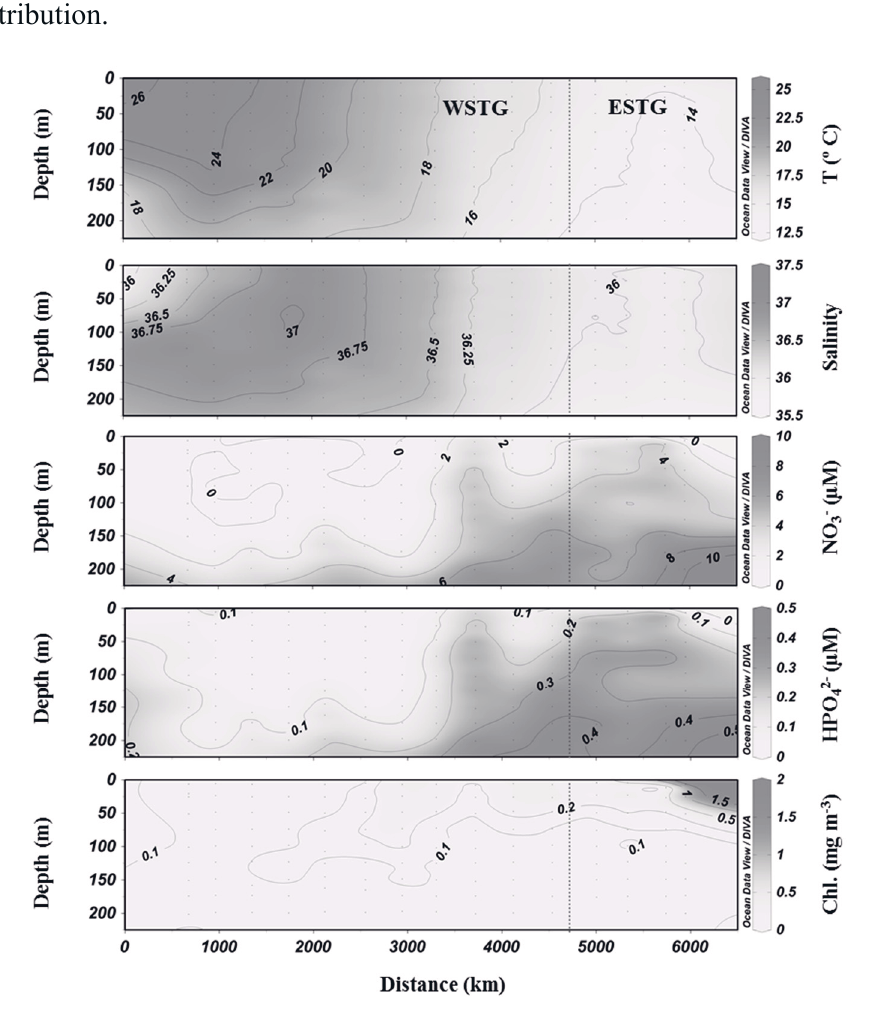
Figure 5. Cross section of sea water density ( ρ ), apparent oxygen utilization (AOU), preformed nitrate (NO 3 pref.) and preformed phosphate (PO 4 pref.) in the upper 200 m of the water column. In each graph the dotted line demarcates the western and eastern parts of the subtropical gyre (WSTG and